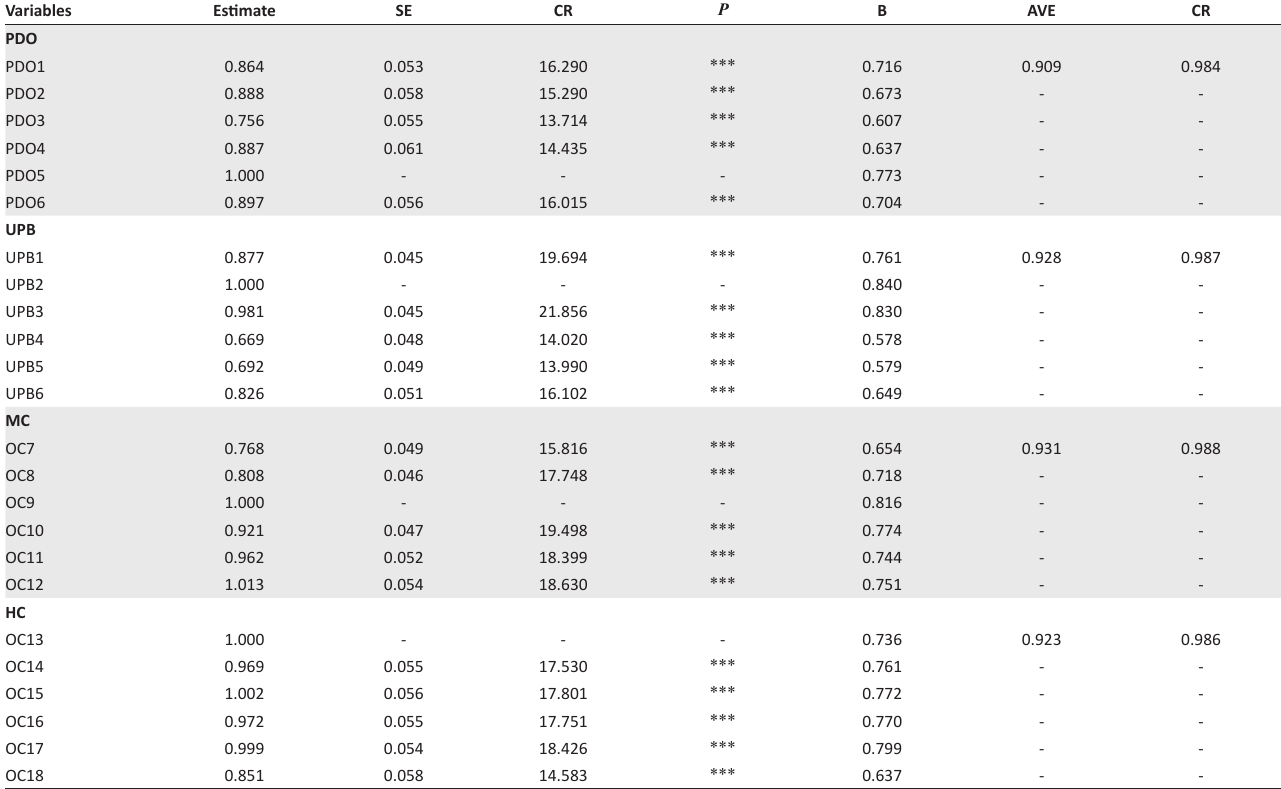
TABLE 3: Results of confirmatory factor analysis and model fit.